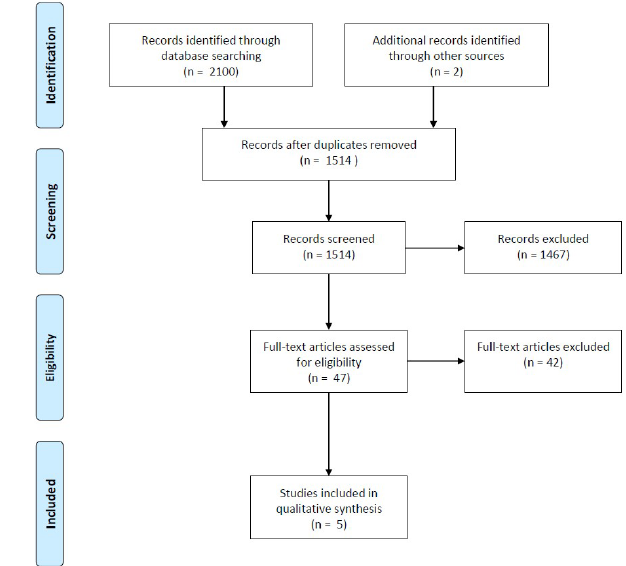
Figure 1. PRISMA flow diagram of the CFRI systematic